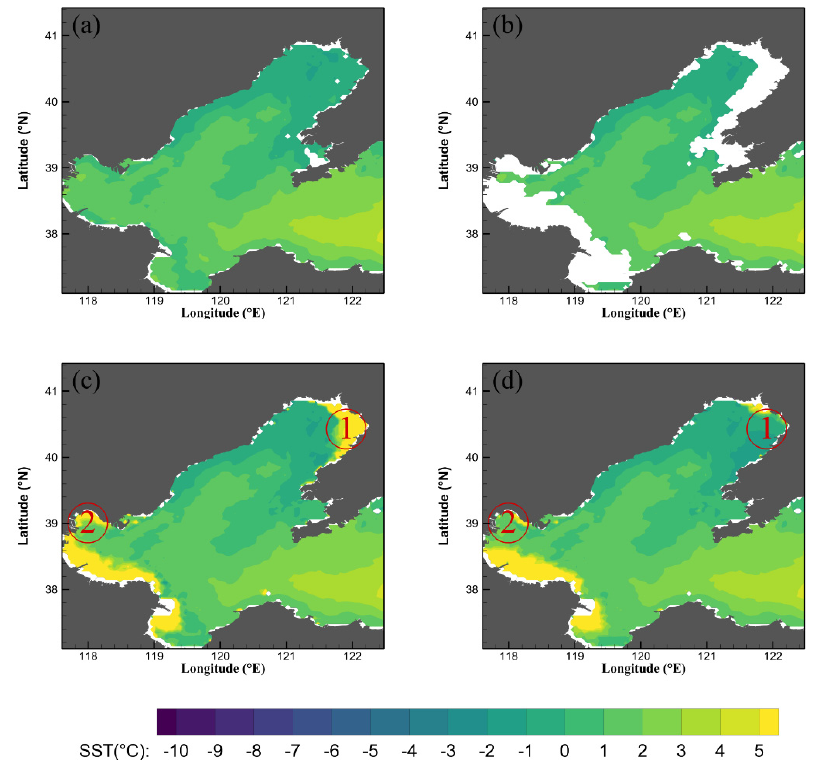
result of the IV − DINEOF algorithm is almost the same as the original data. However, Fig- ure 8c shows that the result of the DINEOF algorithm is not satisfied; specifically, there exist more extreme values in Area 1, Area 2, and along the shoreline. Figure 7. ( a ) Original SST missing data in Feb. 2003, ( b ) Constructed SST missing data according to chl-a, ( c ) Reconstructed SST data using DINEOF, and ( d ) Reconstructed SST data using IV − DINEOF. Compared with the DINEOF algorithm for the July 2010 data, the r of the IV − DINEOF algorithm was improved from − 0.1527 to 0.9075, while the SNR was im- proved from 0.8846 to 2.1632; the RMSE and the MAD decreased from 8.5714 and 5.2358 to 1.1 and 0.7468, respectively. From Figure 8a,d, it can be seen that the reconstruction